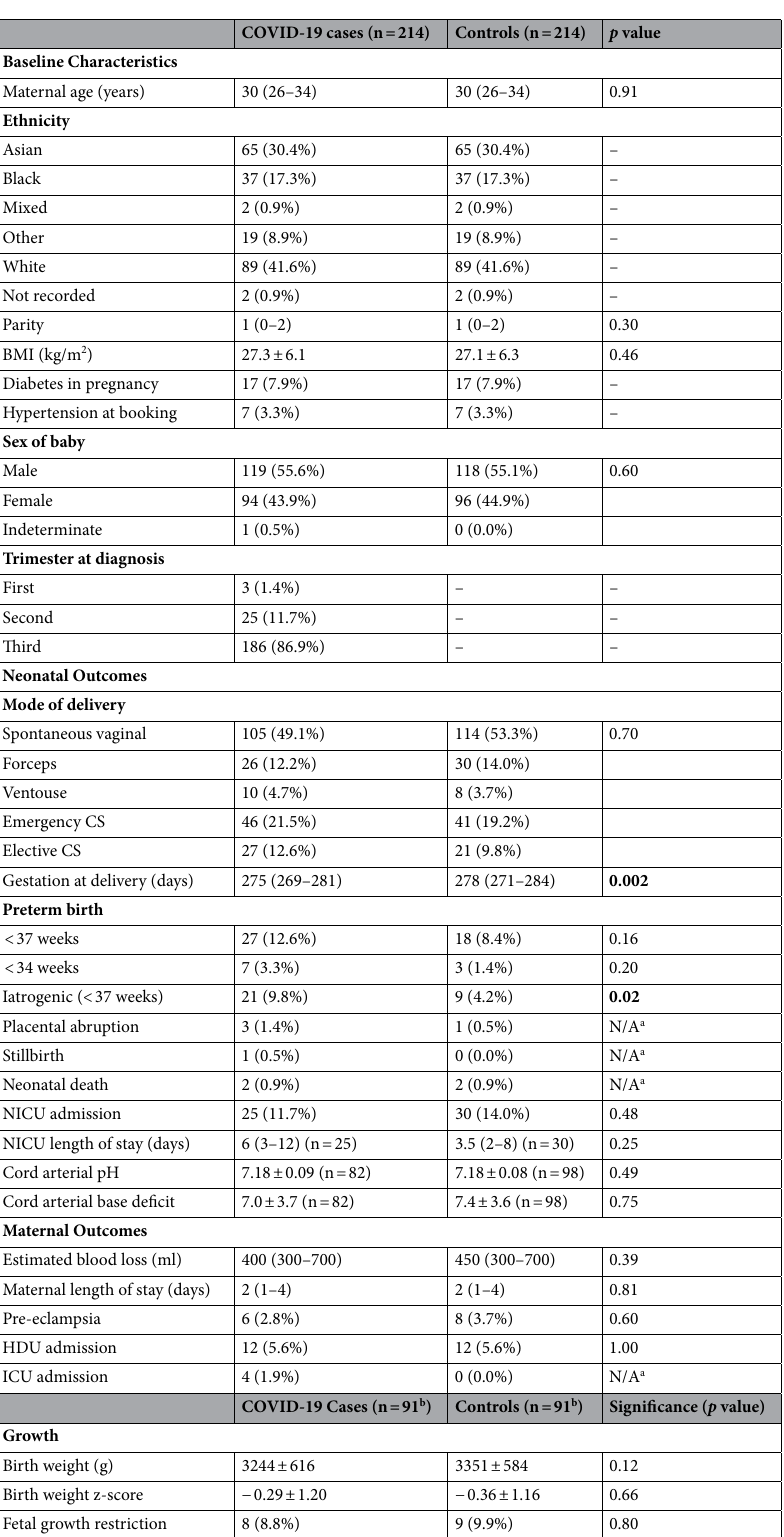
Table 4. Baseline characteristics and outcome data in COVID-19 cases and matched controls. Data are presented as median (IQR), mean ± SD, or number (%) as appropriate for data type and distribution. Comparisons were performed using the chi-squared test, paired and unpaired t-tests, Wilcoxon sign-rank test, and Mann–Whitney U test as appropriate. Significant values are in bold. CS Caesarean section, HDU High dependency unit, ICU Intensive care unit, NICU Neonatal intensive care unit. a Inferential tests statistics are not reported where number of events was less than 5 in both groups. b Only pregnancies where the time between a positive swab and delivery exceeded 14 days are included in analysis of fetal